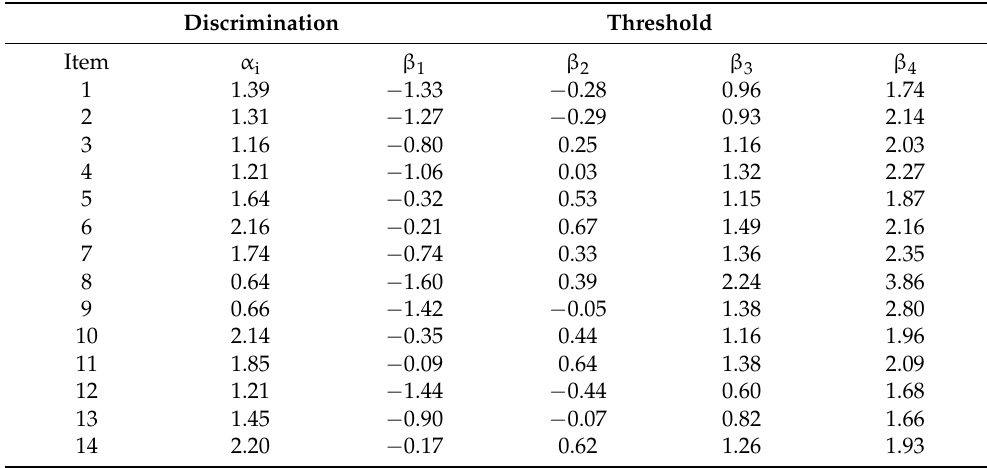
Table 3. Estimates of discrimination and threshold parameters for the Compulsive Internet Use Scale under the graded response model with the LTM